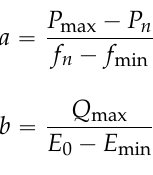
Figure 3. Droop based V/f control.